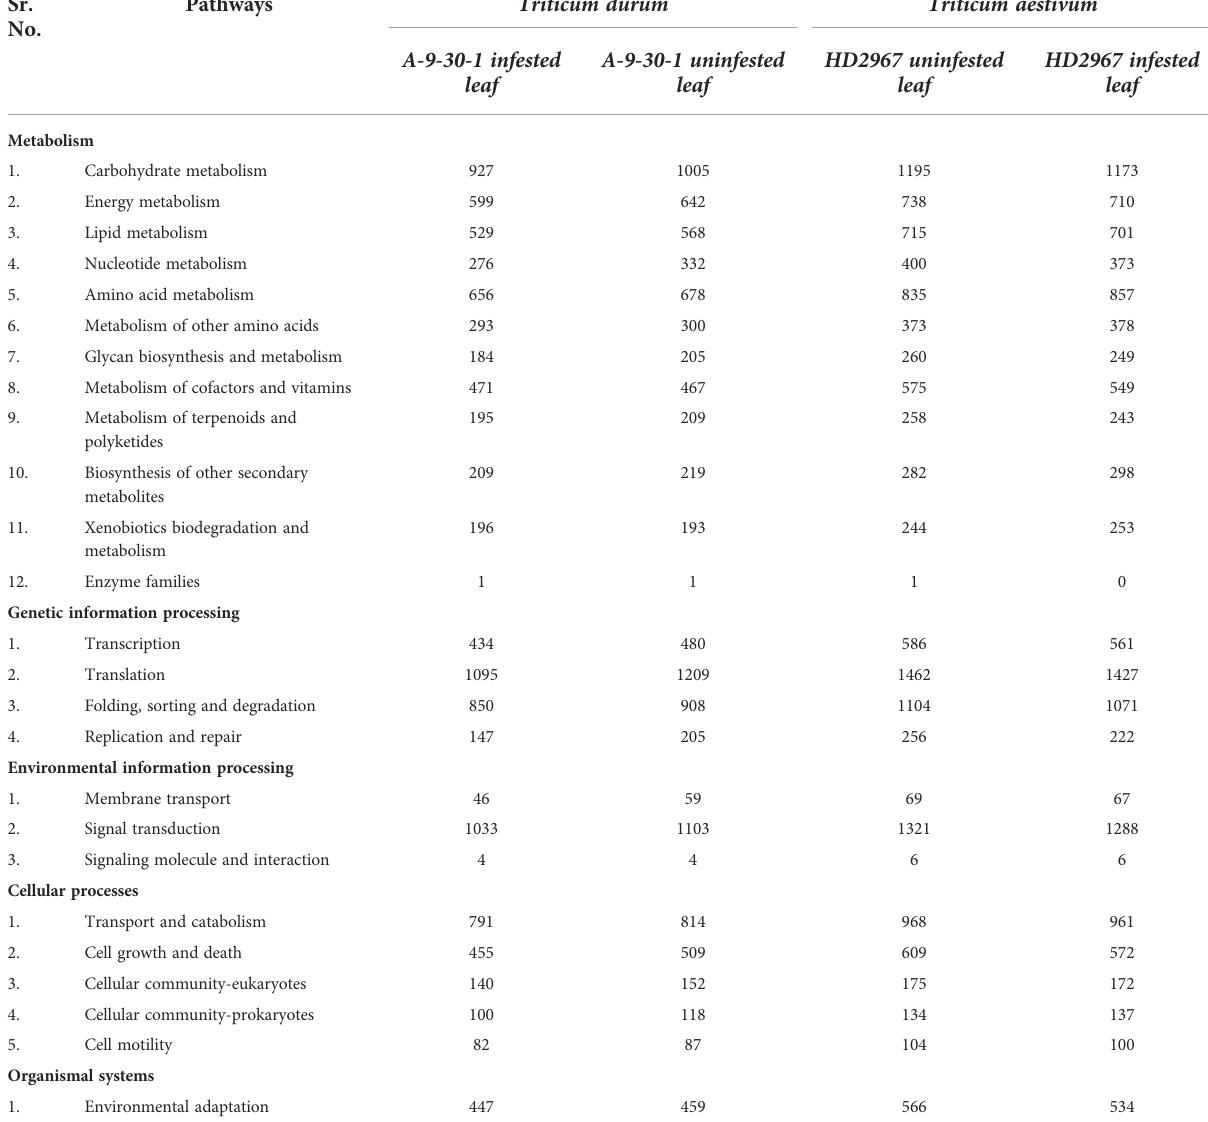
TABLE 3 Classi fi cation of Kyoto Encyclopedia of Genes and Genomes (KEGG) Pathway. Sr.